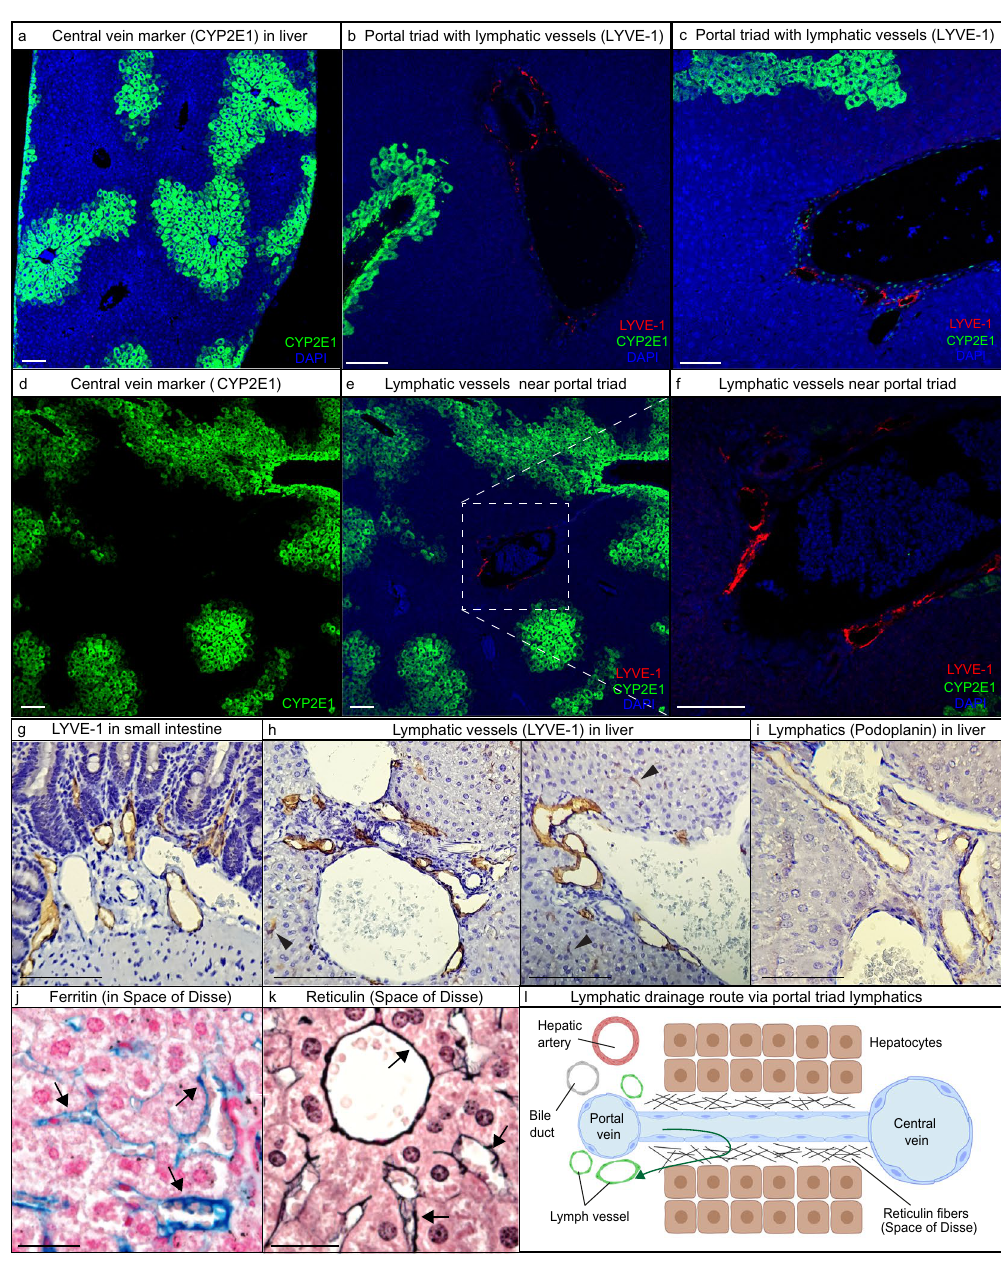
Figure 1. Lymphatic vessels in murine liver exclusively situated in the portal triad interstitium. Fluorescent Multiplex Immunohistochemistry (mIHC) with Tyramide Signal Amplification was used to stain for lymphatic vessels (LYVE-1) in the liver. ( a ) CYP2E1 is expressed by hepatocytes in close proximity to central veins and was used to distinguish portal triad interstitium from central vein interstitium. Scale bar = 100 µm. ( b , c ) Lymphatic vessels (LYVE-1) shown near portal triads. Scale bar = 50 µm. ( d – f ) Lymphatic vessels (LYVE-1) appear exclusively located at the portal triad as no lymphatics are seen near central veins (CYP2E1). Scale bar = 50 µm. ( g – i ) Using LYVE-1 as well as podoplanin to identify lymphatics, similar lymphatic vessels were observed. Arrowheads indicating LYVE-1 also lightly staining sinusoid endothelium 5 . Scale bar = 50 µm. ( j , k ) Representative images of IHC stainings for Perl’s Prussian blue (ferritin) and reticulin fiber (situated in the Space of Disse) suggest ferritin accumulation in the Space of Disse (arrows). Scale bar = 20 µm. ( l ) Schematic overview of lymphatic drainage in liver: from the sinusoids, to the Space of Disse, to lymphatic vessels near the portal